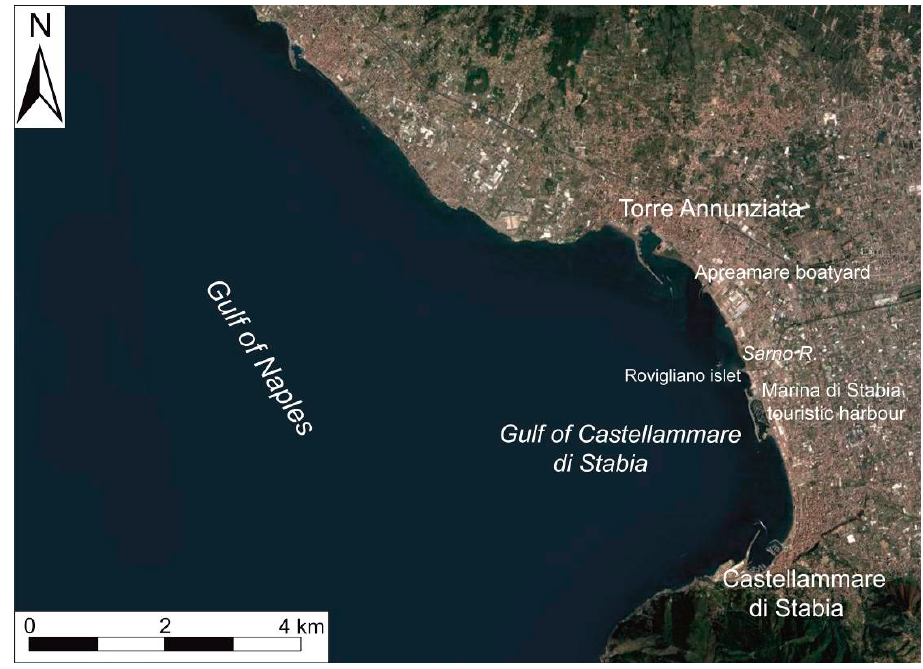
Figure 2. Location, map, and main toponyms of Castellammare di Stabia gulf.